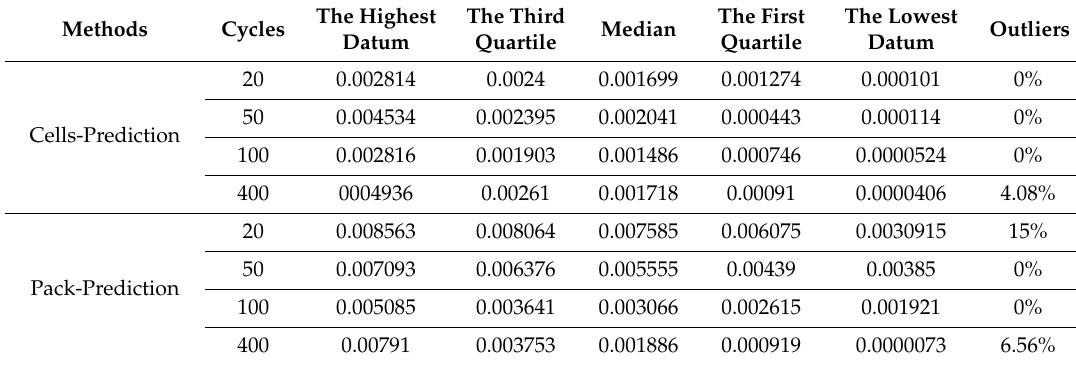
Figure 18. Stability comparison between prediction methods. Table 5. Mean error of di ff erent cycle